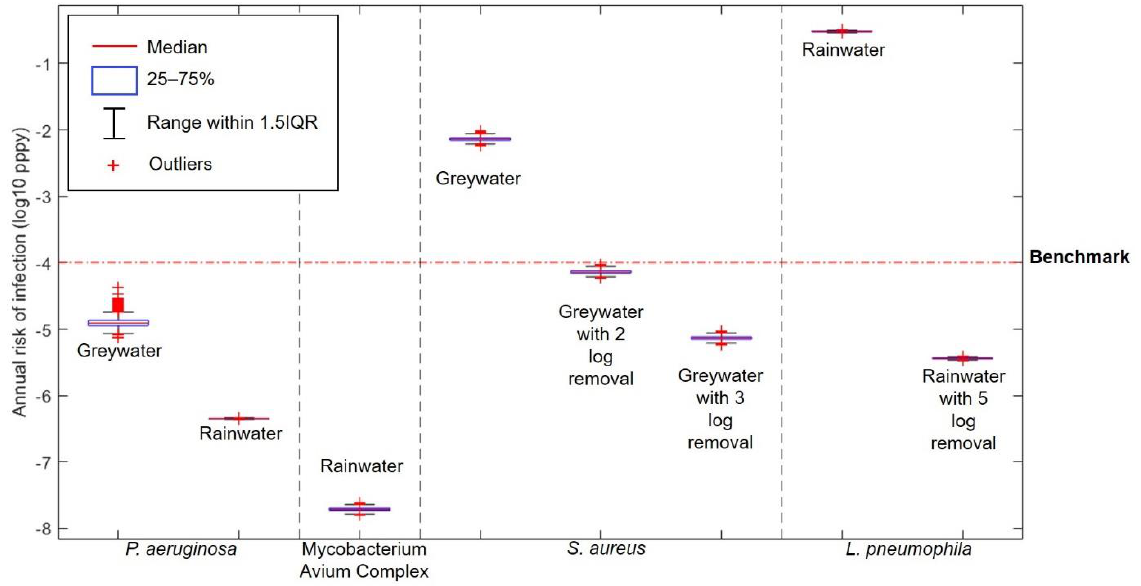
Figure 3. Annual infection risk from showering with cross connected water.